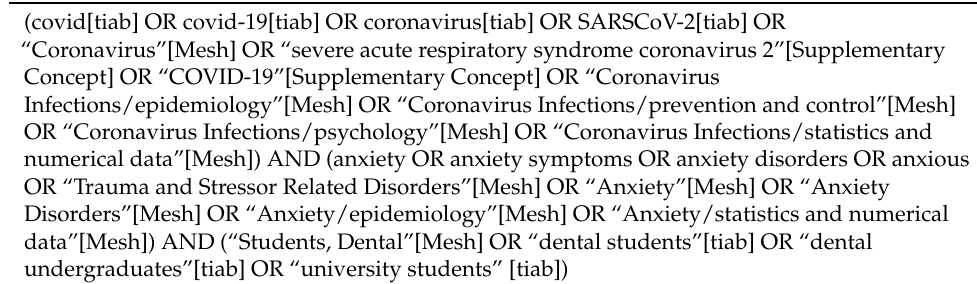
Table 1. Search strategy in